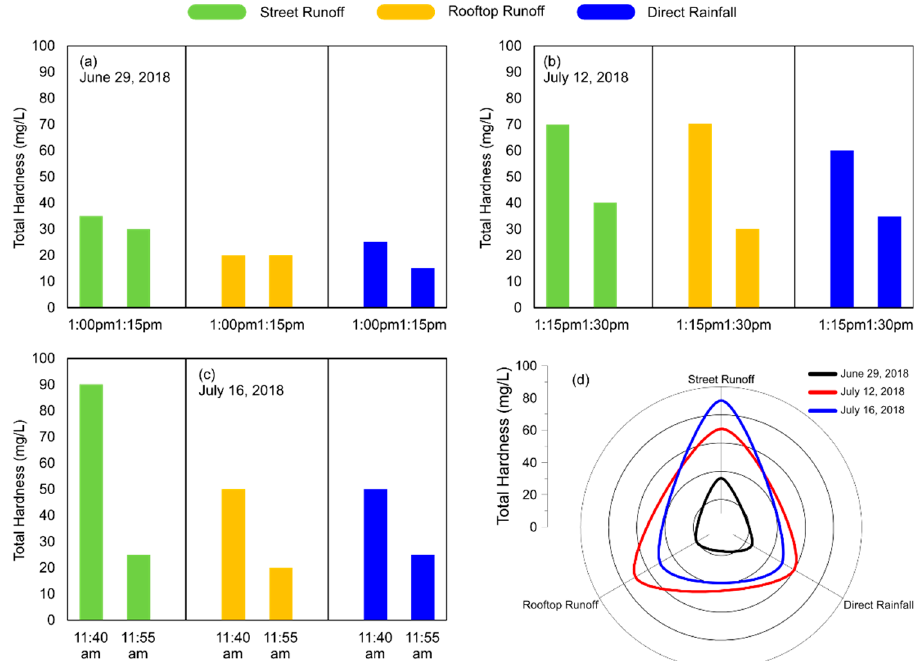
Figure 6. Profile of total hardness (mg/L) in harvested rainwater at Site S1—Irrigation Research Institute, Irrigation Department, Lahore, Pakistan, where ( a ) represents 29 June 2018, ( b ) represents 12 July 2018, ( c ) represents 16 July 2018, and ( d ) illustrates comparative analysis of the three selected dates on polar chart.